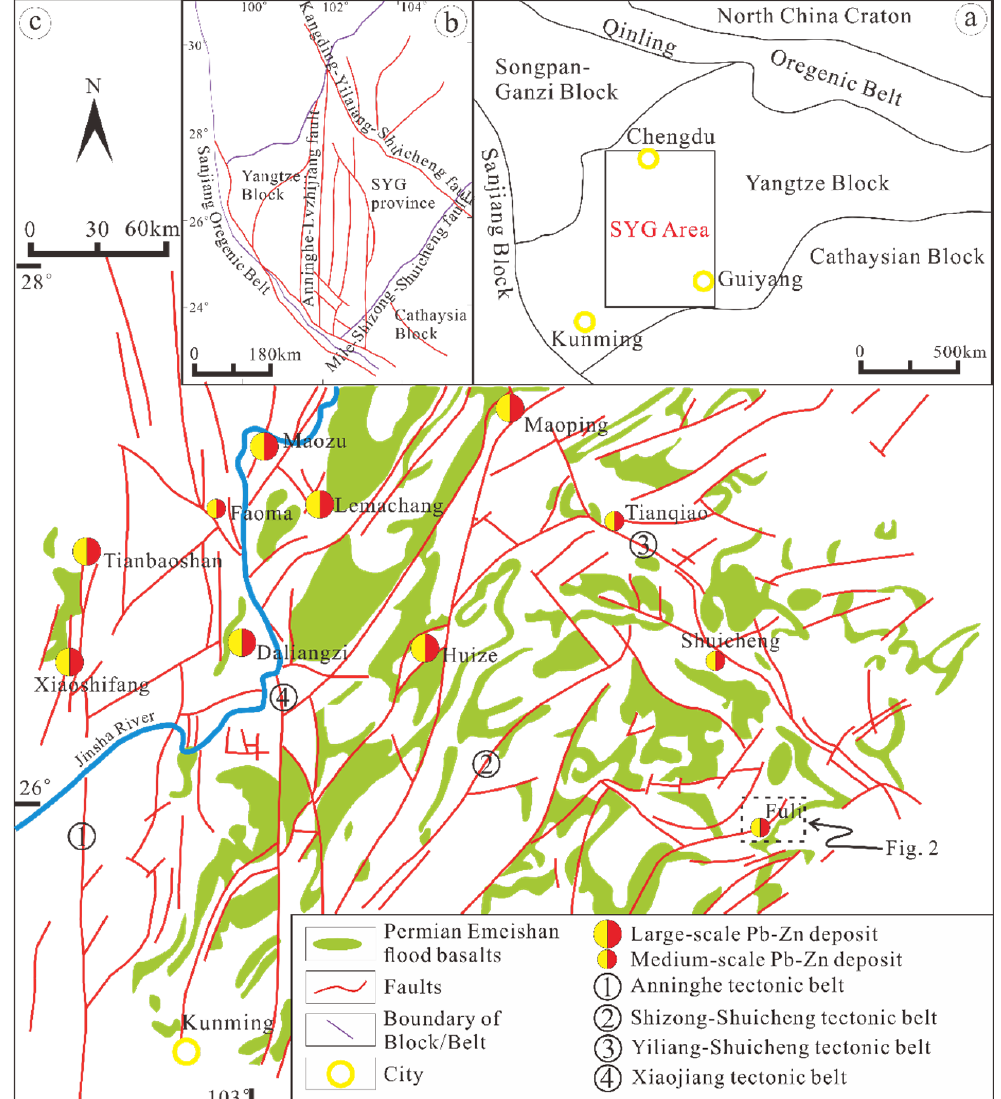
Figure 1. ( a ) Simplified geological framework of SW China showing the SYG province. ( b ) Regional geological setting of SW China. ( c ) A sketched geological map of the SYG metallogenic province showing the distribution of Pb-Zn deposits and Emeishan Flood basalt and location of the Fuli deposit (modified from [3,6,20]).